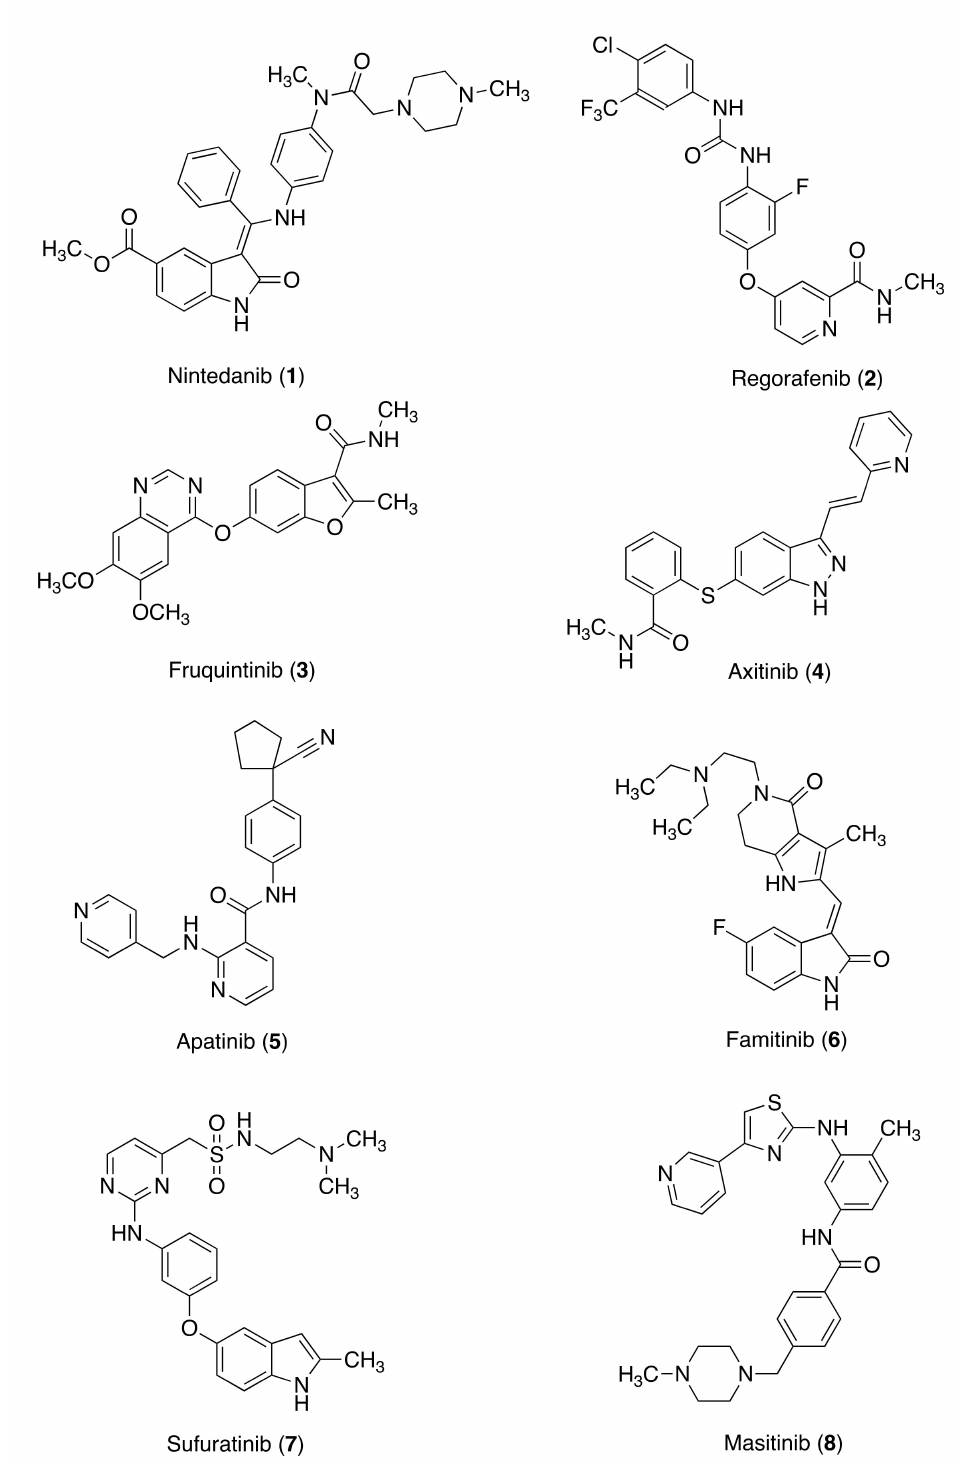
Figure 1. Tyrosine kinase inhibitors targeting VEGF and